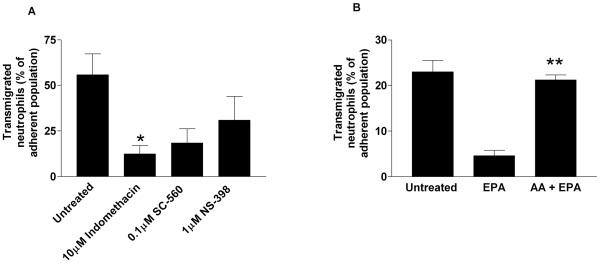
A cyclooxygenase (COX)-derived eicosanoid is required for neutrophil transmigration across TNF-stimulated endothelial cells.(A) Inhibition of COX-1 (SC-560), COX-2 (NS-398), or both (indomethacin) caused inhibition of neutrophil transmigration, *p<0.05 by t-test. (B) Addition of AA to EPA-supplemented endothelial cells during the period of TNF stimulation restored neutrophil transmigration. All data are mean±SEM of four experiments. ANOVA showed significant effects of treatments in both (A and B) (p<0.01). In (A), Dunnett test showed significant effects of individual treatments compared to untreated control, *p<0.05. In (B), Dunnett's test showed significant difference between EPA-treated and untreated control (**p<0.01), but not between AA+EPA and control.